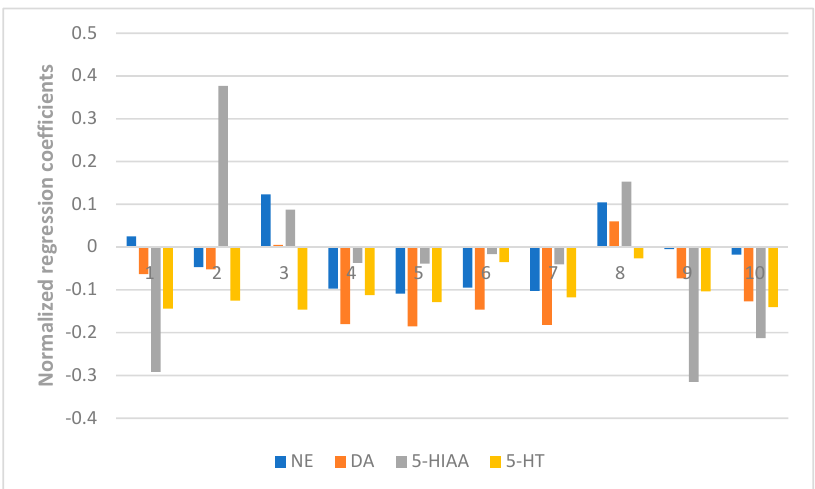
Figure 9. Normalized regression coefficients between the contents of the 10 ZZX samples and the content of monoamine neurotransmitters and their metabolites in the whole cerebral cortex of rats. 1 : Neochlorogenic acid, 2 : Chlorogenic acid, 3 : Cryptochlorogenin acid, 4 : Isochlorogenic acid B, 5 : Isochlorogenic acid A, 6 : Hesperidin, 7 : Isochlorogenic acid C, 8 : Unknown compound X, 9 : Unknown compound Y, 10 : Unknown compound Z. The regression coefficients were combined with the indices of the anti-anxiety effect, of which the regression coefficients of NE, DA, 5-HIAA, 5-HT were either positive, indicating a negative effect on anti-anxiety effect; or negative, indicating a positive effect on anti-anxiety effect.